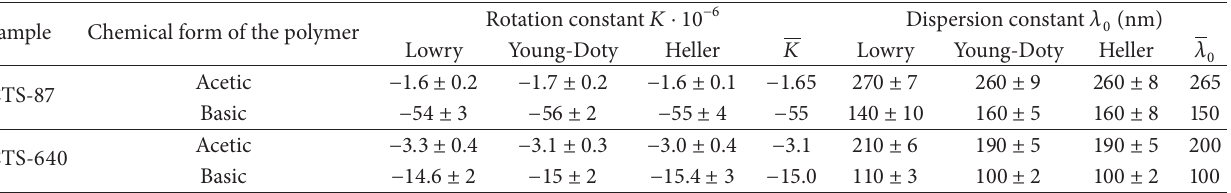
Table 2: Values of the rotation and dispersion constants of chitosan films in two chemical forms.